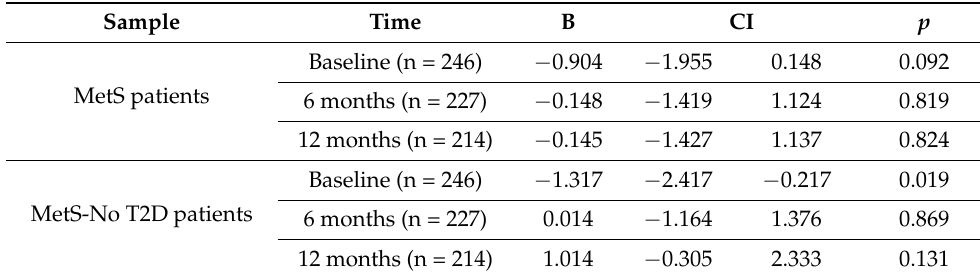
Table 5. Relationship between ucOClevels (log) and CVR.